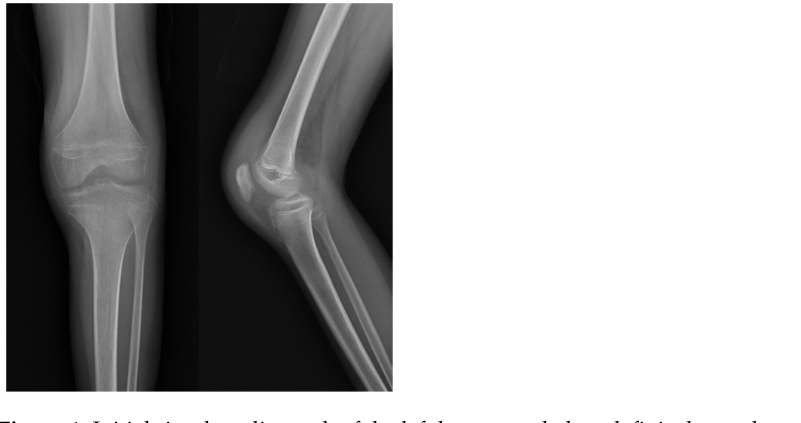
Figure 1. Initial simple radiograph of the left knee revealed no definite bony abnormalities other than moderate soft tissue